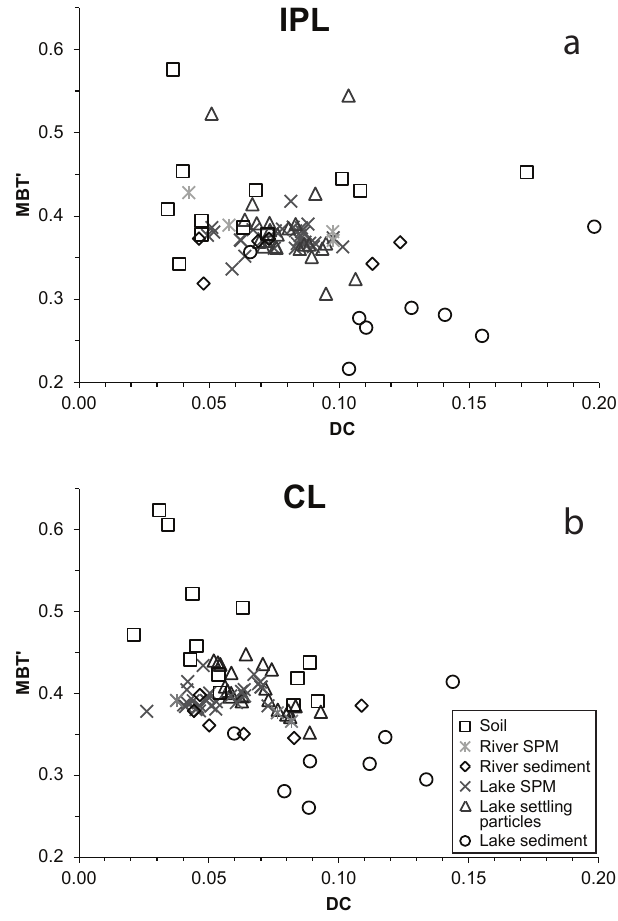
Figure 4. Cross-plots of MBT’ vs. DC of (a) IPL and (b) CL brGDGT lipids showing the differences in distribution between the sample